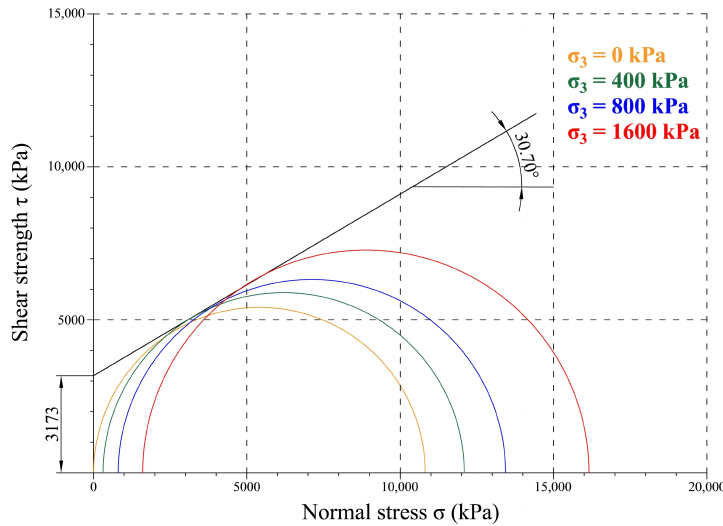
Figure 16. Shear strength of coal.